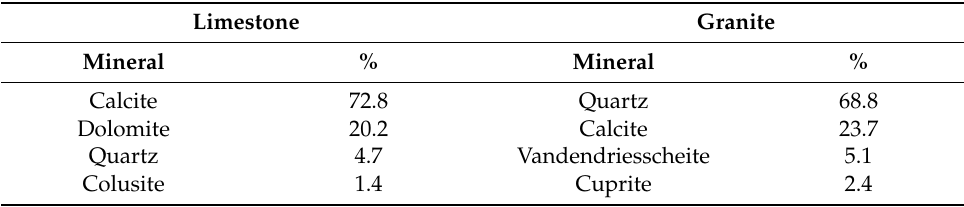
Table 4. XRD analysis for mineralogical